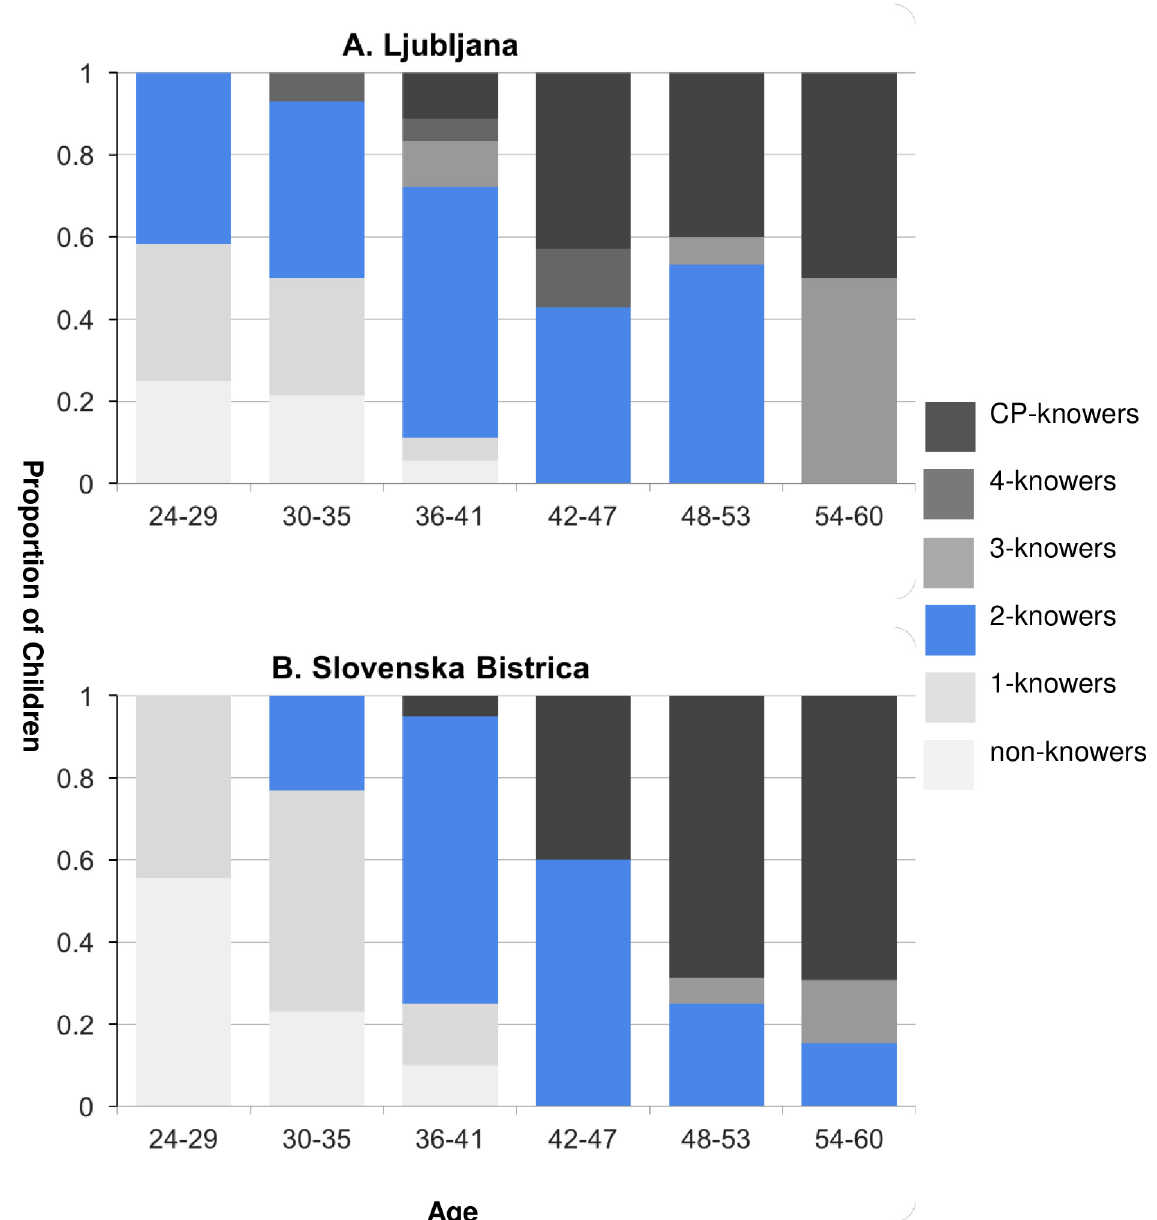
Fig 3. Proportion of dual learning children classified as non-knowers, 1-knowers, 2-knowers, 3-knowers, 4-knowers, and CP- knowers between 22 and 60 months of age in (A) Ljubljana and (B) Slovenska